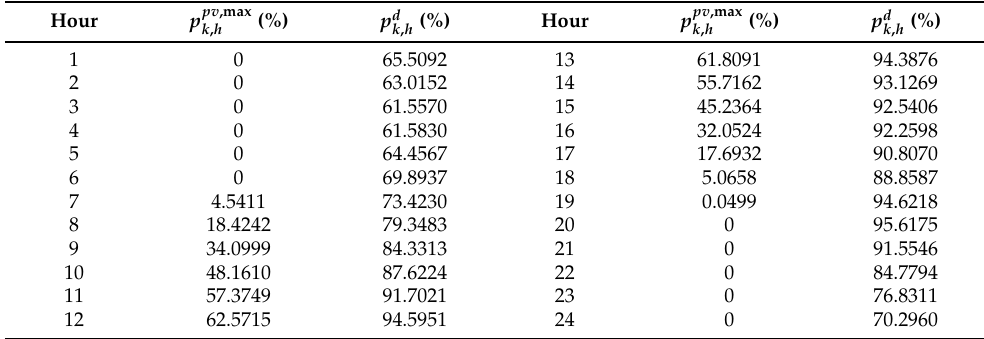
Table 3. Generation and demand